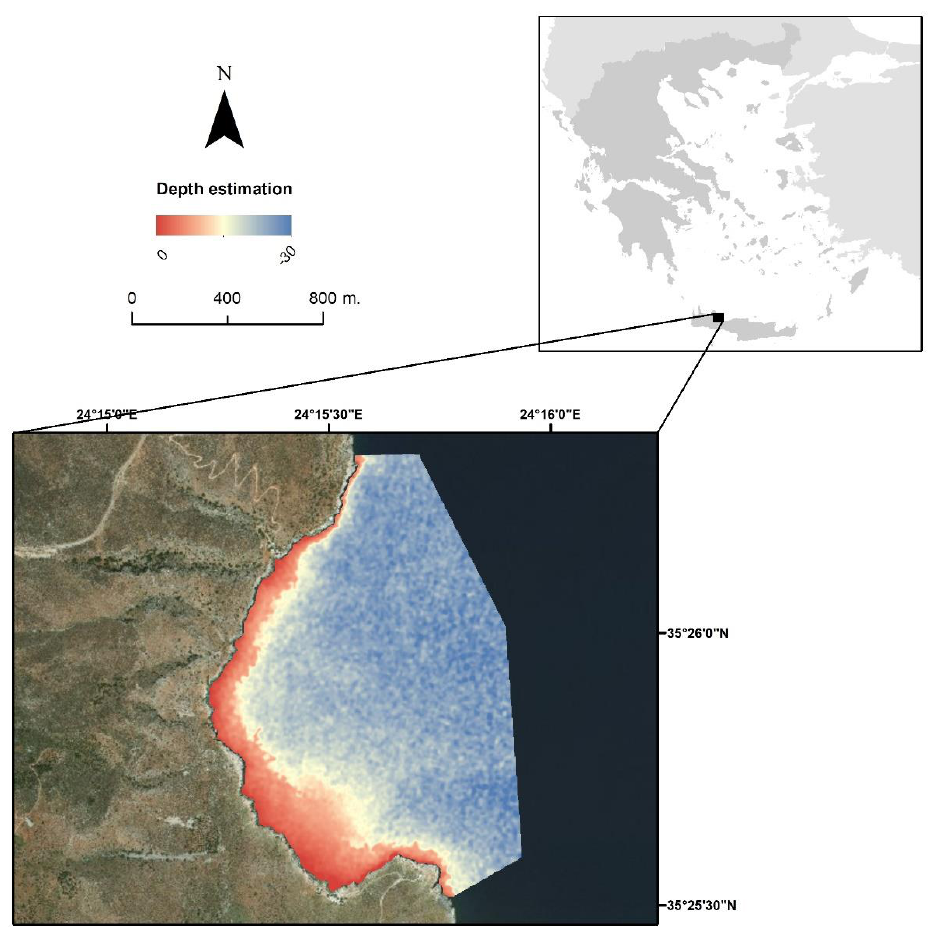
Figure 6. The Satellite-derived bathymetry estimated by the combination of the two-depth zones on the image of 11/07/2017.